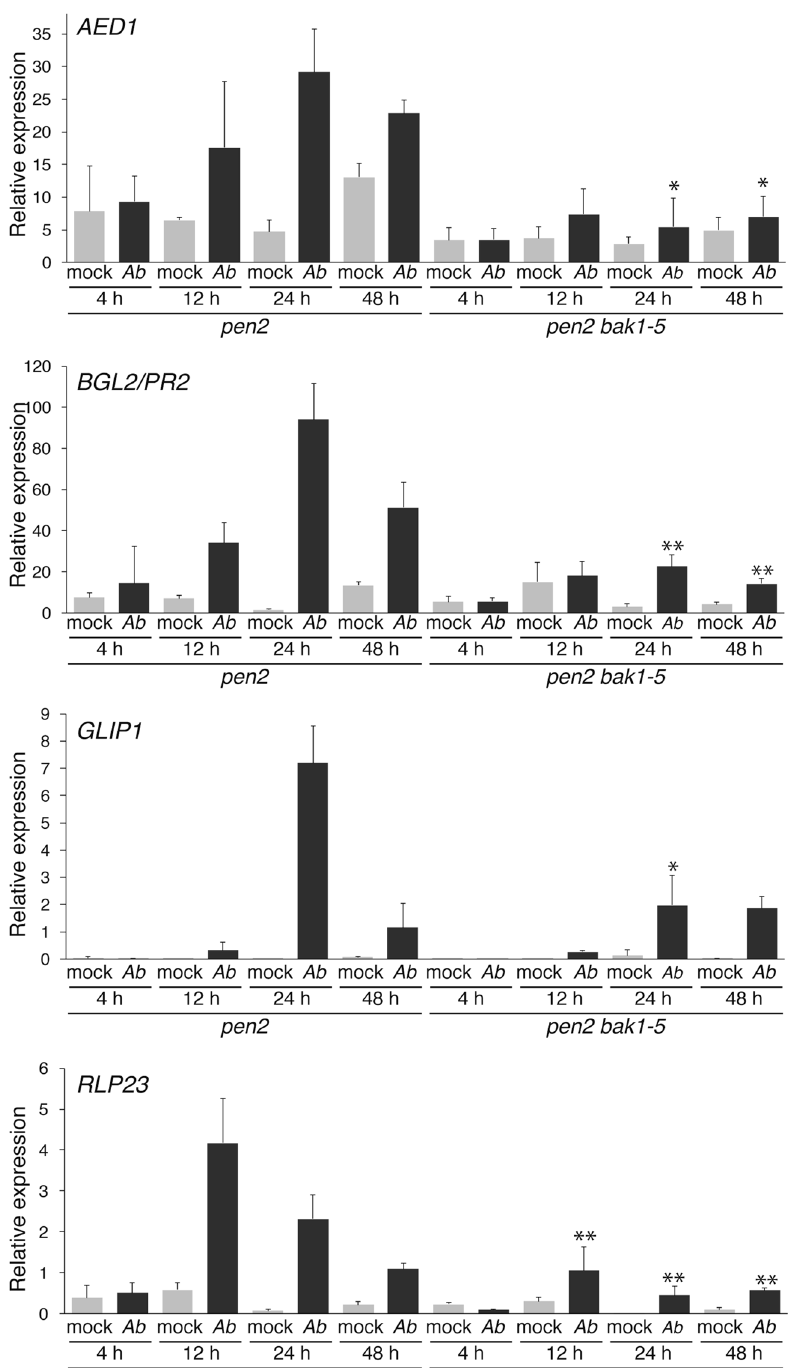
Figure 6. The Ab invasion-triggered expression levels of AED1 , BGL2/PR2 , GLIP1 , and RLP23 were reduced by the bak1–5 mutation. Conidial suspensions (5 × 10 5 conidia/mL) of Ab were spray-inoculated onto 4–5-week-old pen2 and pen2 bak1–5 plants, and then kept at 100% humidity. The samples were collected at 4, 12, 24, and 48 hpi. Each gene transcript was quantified by RT–qPCR using the gene-specific primers listed in Supplementary Table S2. Values were normalized to the expression level of UBC21 . The means and SDs were calculated from three independent experiments. The statistical analysis was conducted by a two-tailed t test. The expression levels of each gene between pen2 and pen2 bak1–5 were compared at the same time points and treatment (* P < 0.05; ** P <